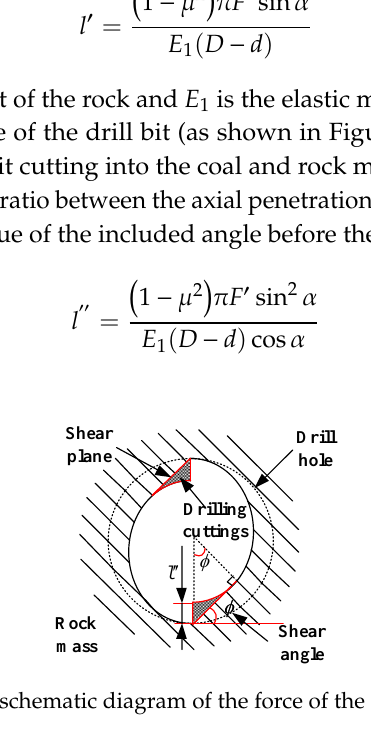
Figure 4. Schematic diagram of a bit invading rock.